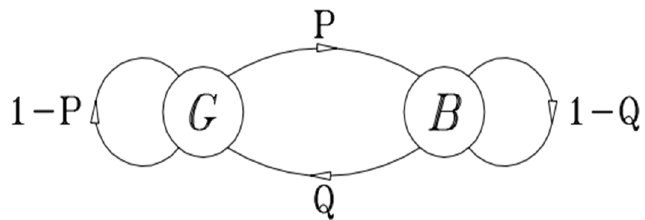
Figure 1. Gilbert Elliot channel (GEC) model.